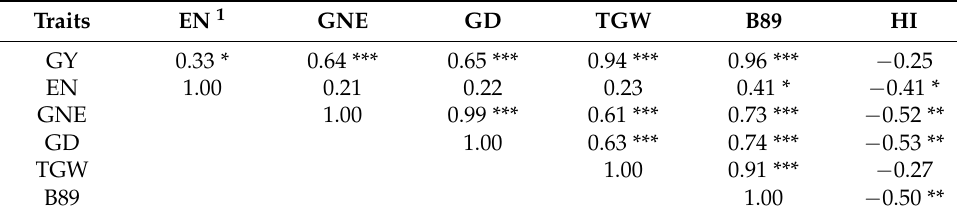
Table A1. Correlation matrix of basic yield components and yield of winter wheat, n = 36.